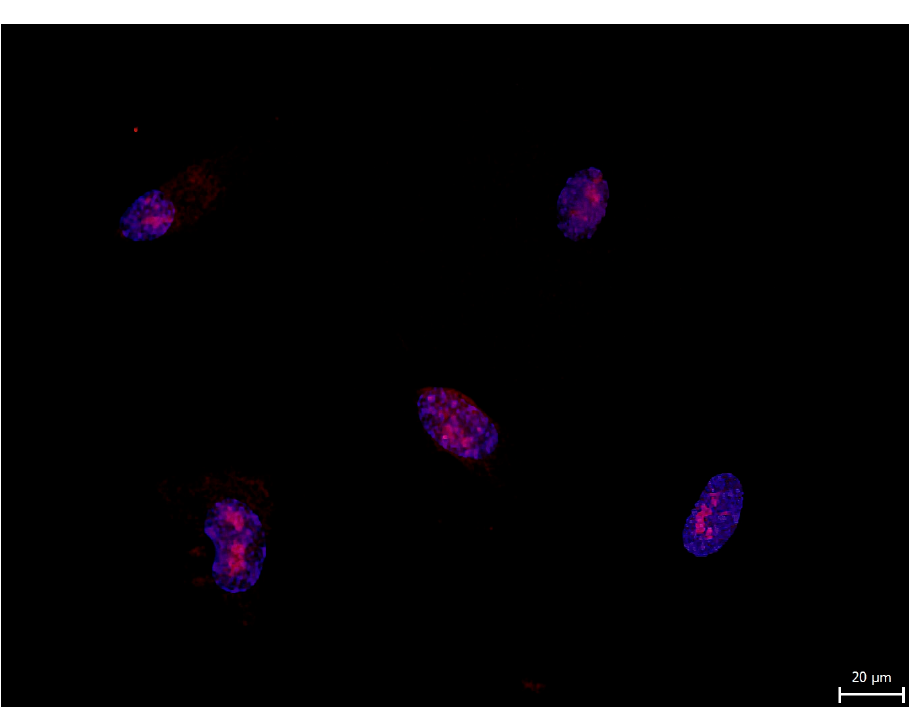
Figure 5. Human telomerase reverse transcriptase (hTRT, red areas) is expressed inside the nuclei (blue) of DPSCs from the 2 nd passage. Scale bar 20 µm.